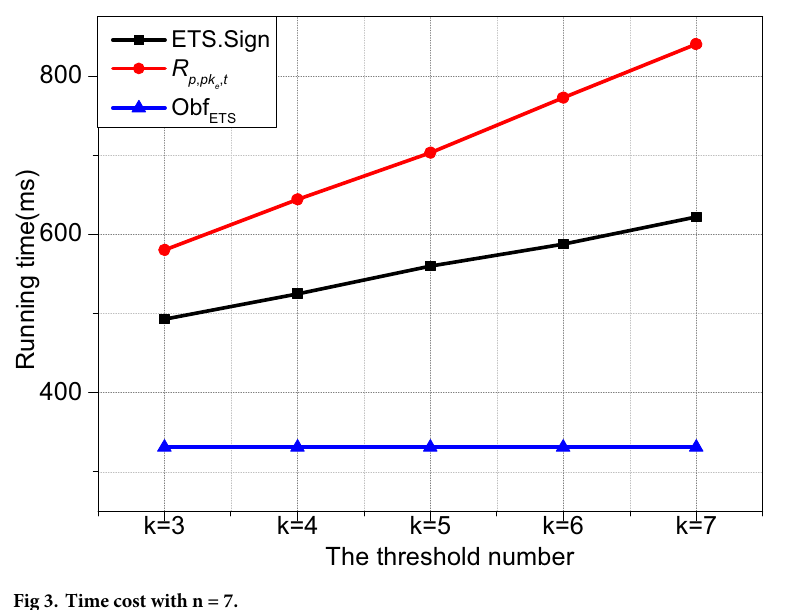
Fig 3. Time cost with n =